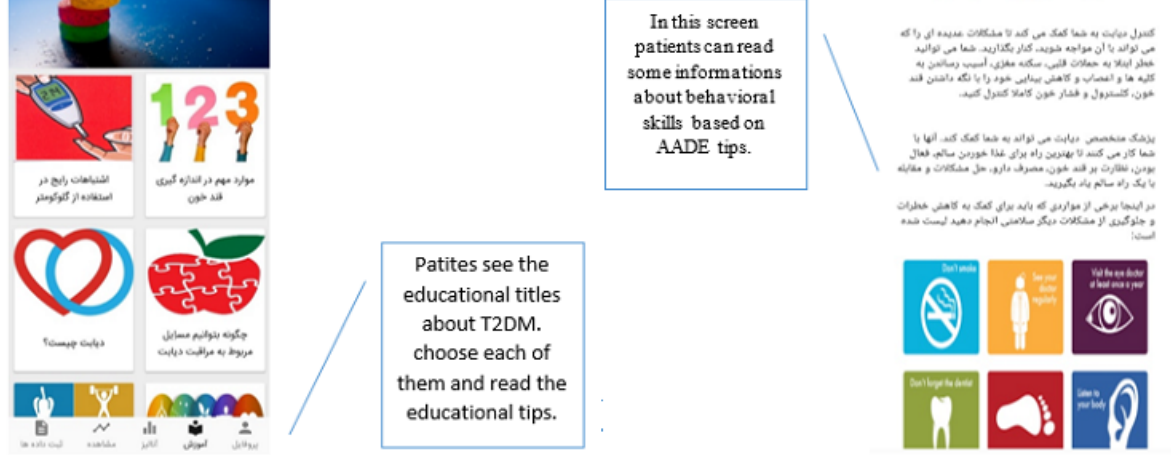
Figure 5. Education module: participants will learn tips on controlling diabetes, improving problem-solving skills, reducing risks, and healthy